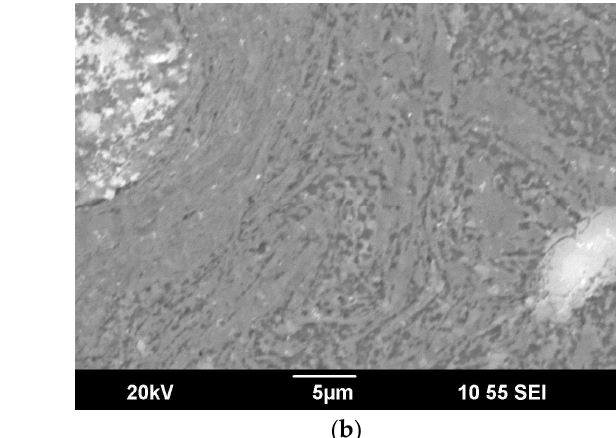
Figure 9. Micrographs of the MPEA_HIP sample: ( a ) light optical image, and ( b ) secondary electron image.